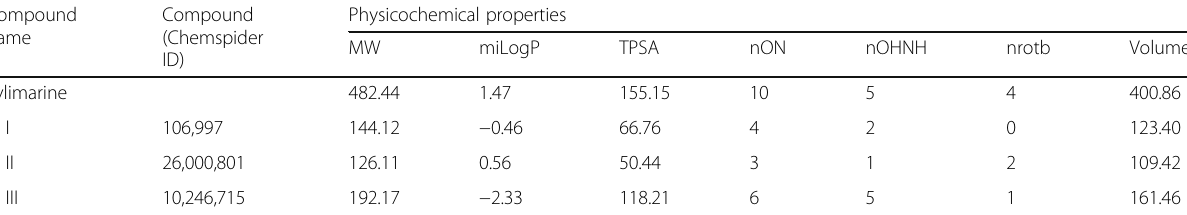
Table 3 Physicochemical properties